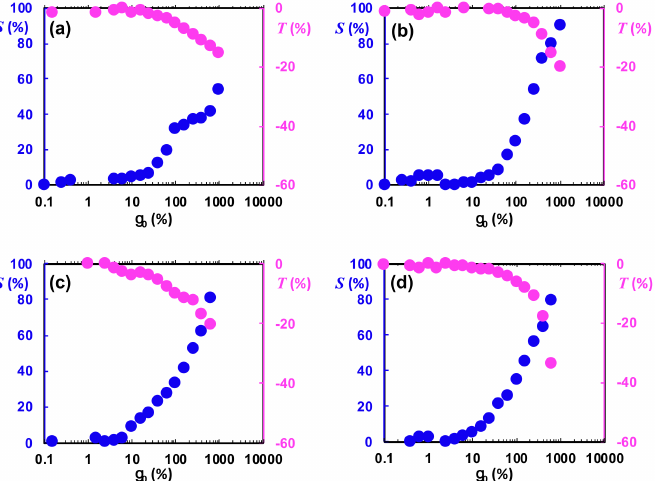
Figure 14. Elastic ( S ) and viscous ( T ) intra-cycle nonlinearity indices as a function of imposed strain amplitude for ( a ) PP:PS/70:30/MWCNT 1 vol.%, ( b ) PP:PS/70:30/MWCNT 1 vol.%/SB D0243K 5 vol.%, ( c ) PP:PS/70:30/MWCNT 1 vol.%/SB D1431P 5 vol.%, and ( d ) PP:PS/70:30/MWCNT 1 vol.%/SBS D1102K 5 vol.% blend